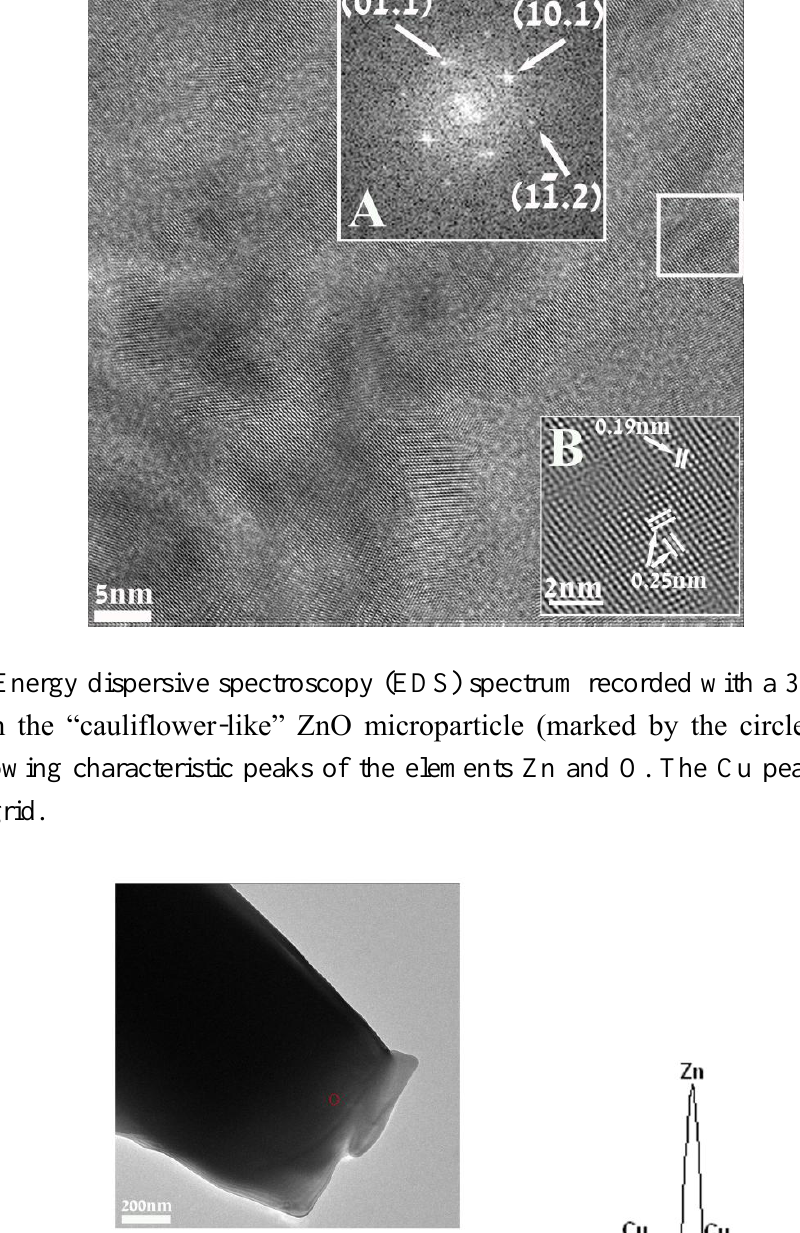
Figure 3. High Resolution (HRTEM) electron micrograph of a nanoparticle resulting in this reaction. Inset ( A ) is the indexed Fourier Transform (FFT) taken from the area marked by the white square. The indexing corresponds to the hexagonal structure describing of ZnO. Inset ( B ) represents the magnified and processed portion of the image outlined by the white square, displaying the interplanar spacing for d